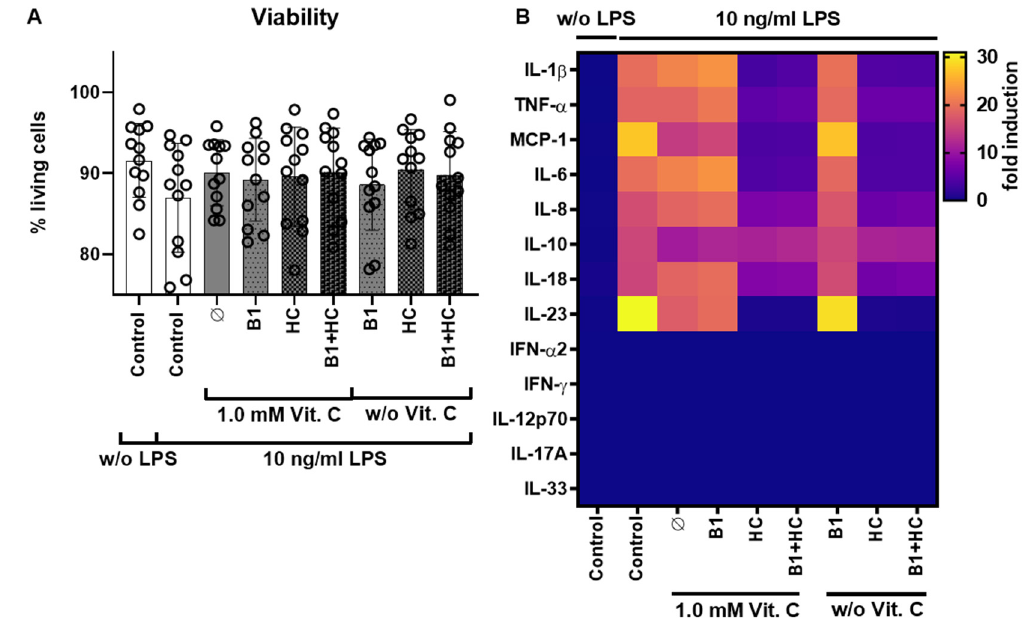
Figure 3. PBMC viability analysis and cytokine secretion analysis after vitamin C, vitamin B1, and hydrocortisone treatment. ( A ) The viability of PBMCs measured by Countess™ II FL Automated Cell Counter and a trypan blue staining) was at a comparable level in all donors (6 females (F), 6 males (M)) after the start of the 6 h combination treatment of Vit. C, B1, or HC alone or in combination and with (10 ng/mL) or without LPS. ( B ) Heat map analysis of the cytokine secretion measured with the LEGENDplex TM human inflammation panel 1 via flow cytometry, after treatment of the cells for 6 h with either Vit. C (1 mM), B1 (1 µM), and HC (2 µM) alone or in combination and with or without LPS; shown is the fold induction compared to the control w/o LPS. Additional data analysis stratified according to gender is available as Figure S4. B1 = vitamin B1; HC = hydrocortisone; IFN = interferon; IL = interleukin; LPS = bacterial lipopolysaccharides; MCP = monocyte chemo-attractant protein; PBMCs = peripheral blood mononuclear cells; TNF = tumor necrosis factor; Vit. C = vitamin C.